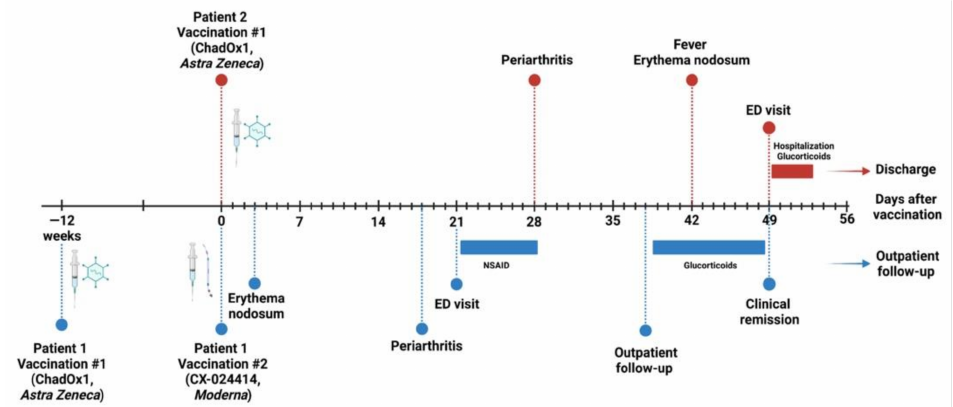
Figure 2. Time course of Löfgren’s syndrome in relation to vaccination in both patients. Cre- ated with BioRender.com. Abbreviations: ED, emergency department; NSAID, non-steroidal anti- inflammatory